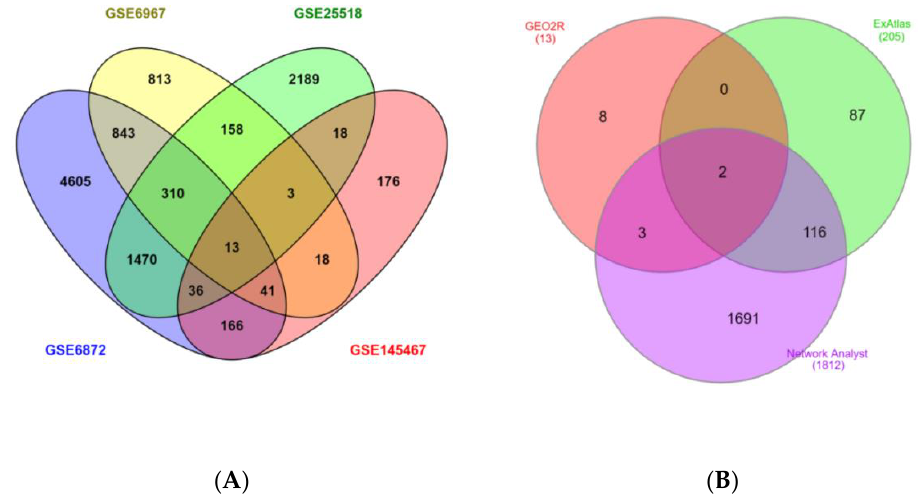
Figure 7. Venn diagrams showing the expression profiles of the study datasets. ( A ) The number of common genes obtained by GEO2R from the two teratozoospermia and two azoospermia datasets as visualized by a Venn diagram; 13 genes were found common to teratozoospermia and azoospermia among the four datasets, ( B ) common genes of individual analyses of the four datasets of teratozoospermia and azoospermia by three different software programs, i.e., ExAtlas, Network Analyst, and GEO2R. Only 2 genes were found common among the individual results obtained across the three analyses, CCDC90B and CCDC91.